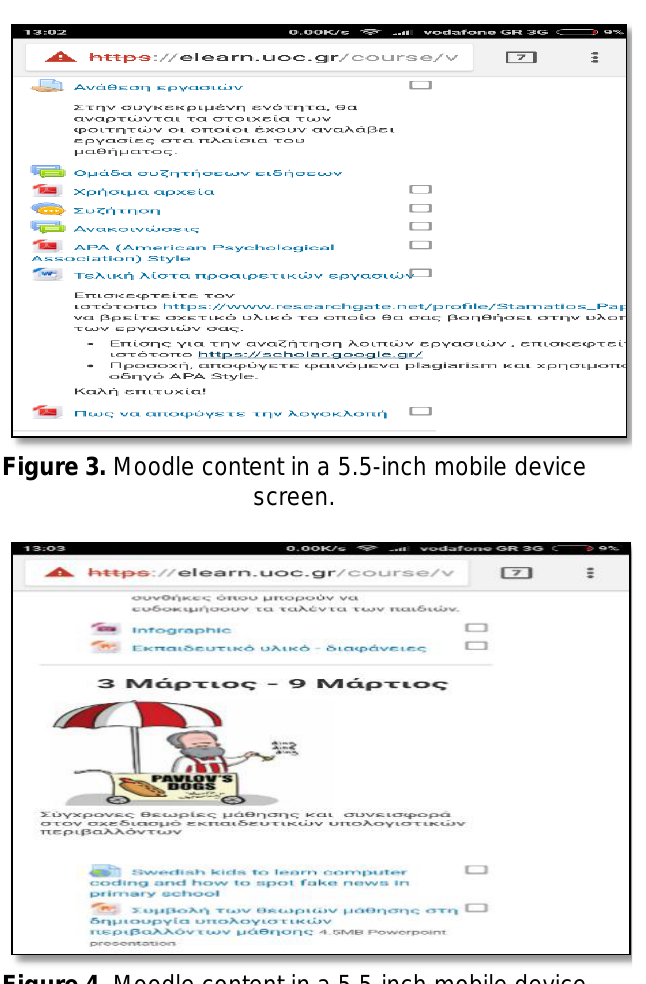
Figure 4. Moodle content in a 5.5-inch mobile device screen